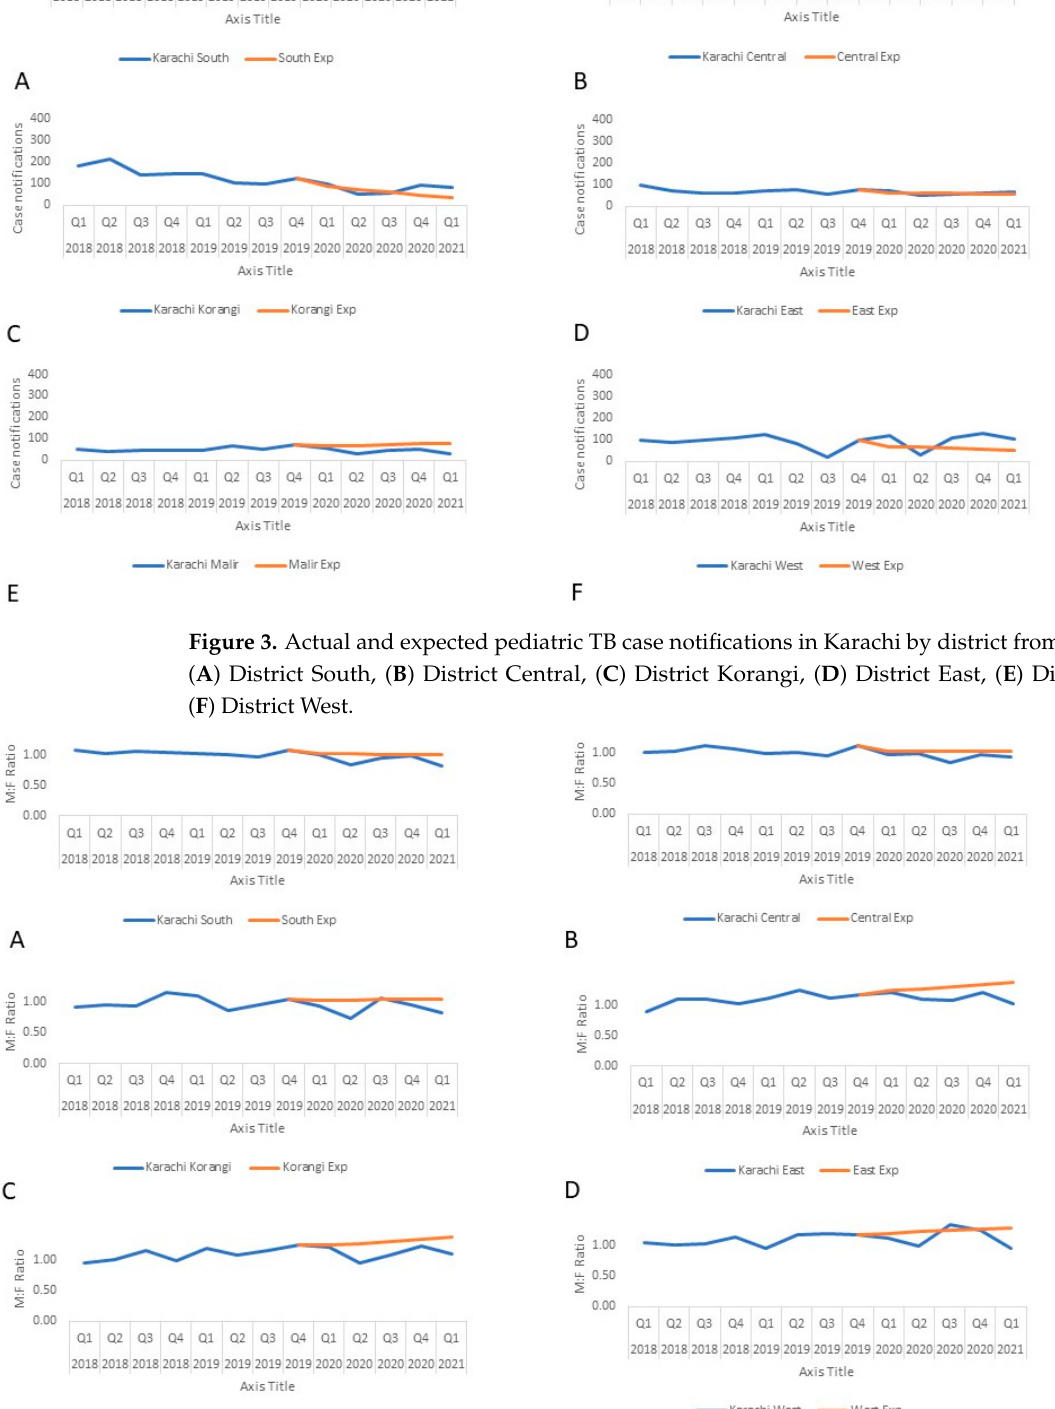
Figure 4. Actual and expected male to female ratio of TB case notifications in Karachi by district from 2018–2021: ( A ) District South, ( B ) District Central, ( C ) District Korangi, ( D ) District East, ( E ) District Malir, ( F ) District West.